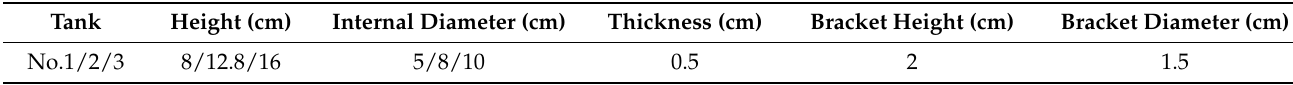
Table 2. Parameters of oil storage tank.